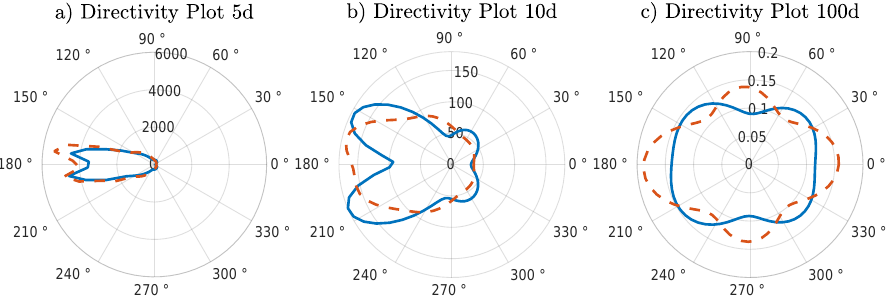
Figure 13. Directivity plot of the p rms [Pa] determined by the nonlinear solution of the FW-H equation on points placed on concentric circles at ( a ) r = 5 d , ( b ) r = 10 d and ( c ) r = 100 d . Solid line, rigid cylinder; dashed line, flexible